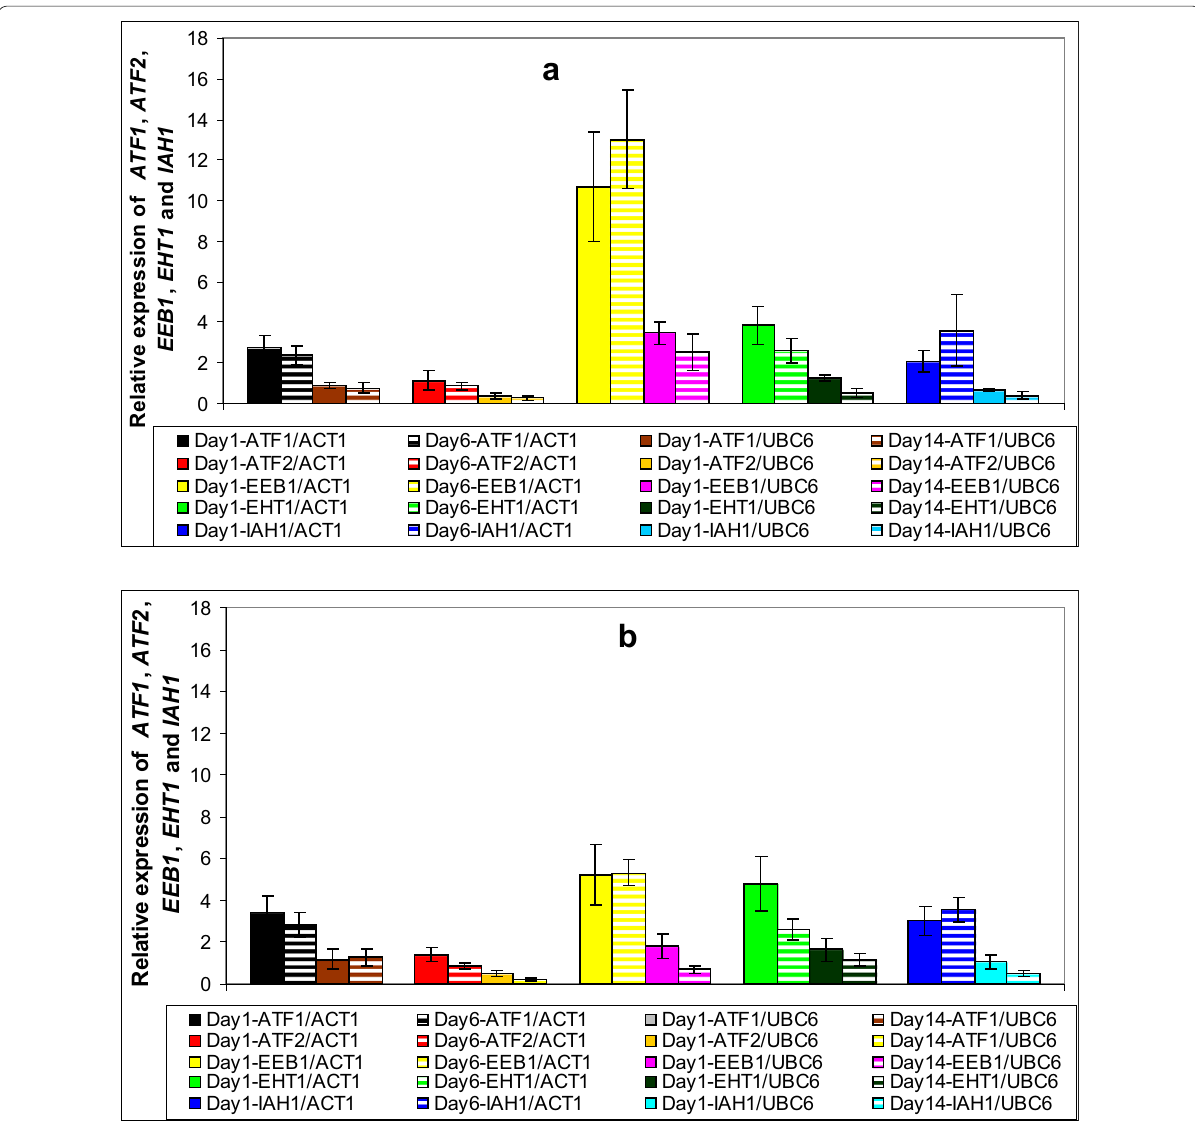
Fig. 5 Expression of ester biosynthesis genes ATF1, ATF2, EEB1, EHT1, IAH1 during Debina must fermentations. a Strain VL1 and b strain Z622. In ( a ) and ( b ): gene expression on day 1 was normalized against the expression levels of both ACT1 and UBC6 genes, whereas: (i) on day 6 expression values were normalized against ACT1 and (ii) on day 14 against UBC6. In each set of values, the first bar corresponds to day 1 normalized against ACT1 , second bar to day 6 normalized against ACT1, third bar to day 1 normalized against UBC6 and fourth bar to day 14 normalized against